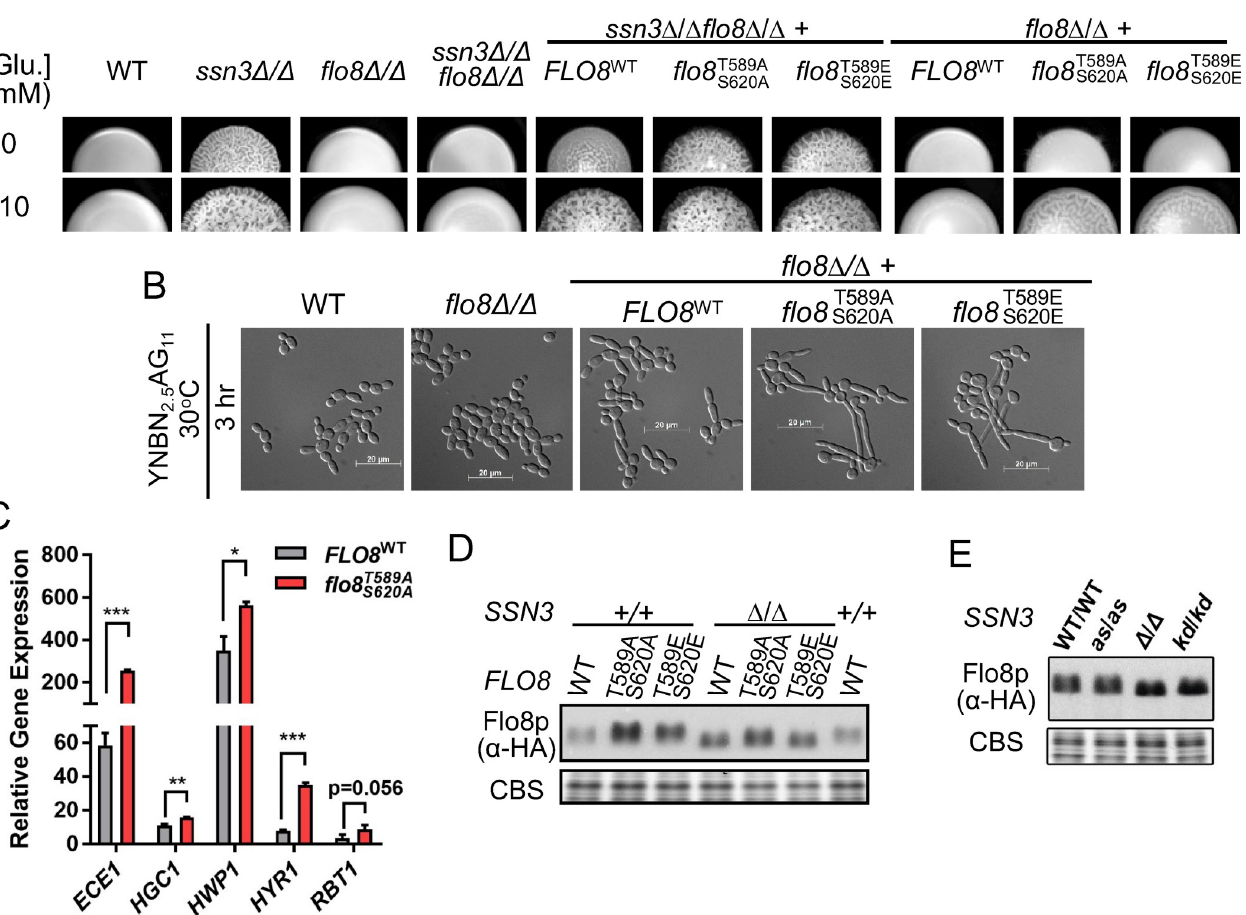
Fig 6. Alteration of Flo8 phosphosite residues influences Flo8 function. A.Wild type (WT), ssn3 Δ / Δ , flo8 Δ / Δ and ssn3 Δ / Δ flo8 Δ / Δ strains were imaged after growth as colonies on YNBA or YNBA+110 mM glucose at 37˚C. In addition, ssn3 Δ / Δ flo8 Δ / Δ or flo8 Δ / Δ were complemented with constructs that encoded Flo8 WT , Flo8 T589A/S620A or Flo8 T589E/S620E with C-terminal 3XHA tags. B. Cell morphology of WT, flo8 Δ / Δ , and flo8 Δ / Δ expressing 3XHA-tagged Flo8 WT , Flo8 T589A,S620A or Flo8 T589E,S620E after growth in YNBN 2.5 AG(11 mM glucose) at 30˚C for 3h. C. Expression of hypha-associated transcripts in flo8 Δ / Δ expressing either 3XHA-tagged Flo8 WT or Flo8 T589A/S620A after growth in YNBNAG for ~2h . Data are normalized levels of the corresponding transcript in flo8 Δ / Δ . Data show the mean and standard deviation from measurement on triplicate RNA samples. P-values, determined by t-test, indicated by � , p < 0.05; �� , p < 0.01; ��� , p < 0.001; or the specific value was indicated. D. Immunoblotting analysis on 10% SDS-PAGE with an α -HA antibody shows levels and mobility of 3X-HA derivatives of Flo8, Flo8 T589A/S620A or Flo8 T589E/S620E in either WT or ssn3 Δ / Δ . CBS indicates levels of Coomassie Blue stained total protein in a different region of the blot and is used as a loading control. E. Immunoblot of Flo8-HA levels and mobility on 10% SDS-PAGE in strains with full Ssn3 activity, WT, ssn3 AS , ssn3 Δ / Δ ( Δ / Δ ) or ssn3 KD (which expresses the kinase dead variant; kd/kd ). CBS indicates levels of Coomassie Blue stained total protein in the region of the target protein, and is used as a loading control.